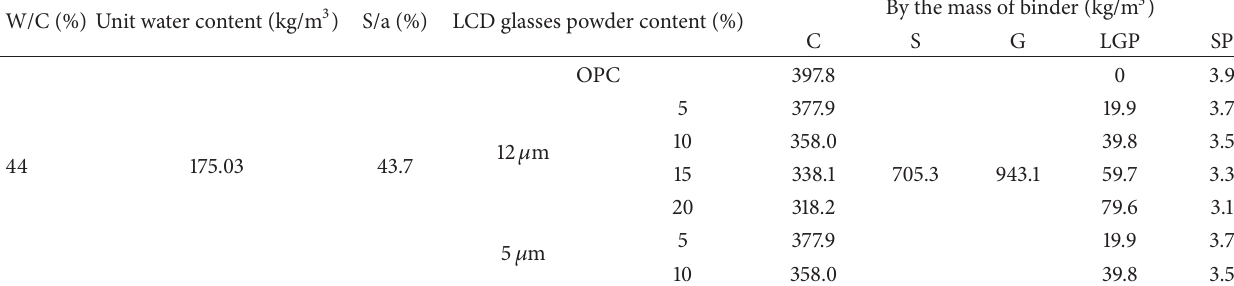
Table 3: Mix proportions of concrete with